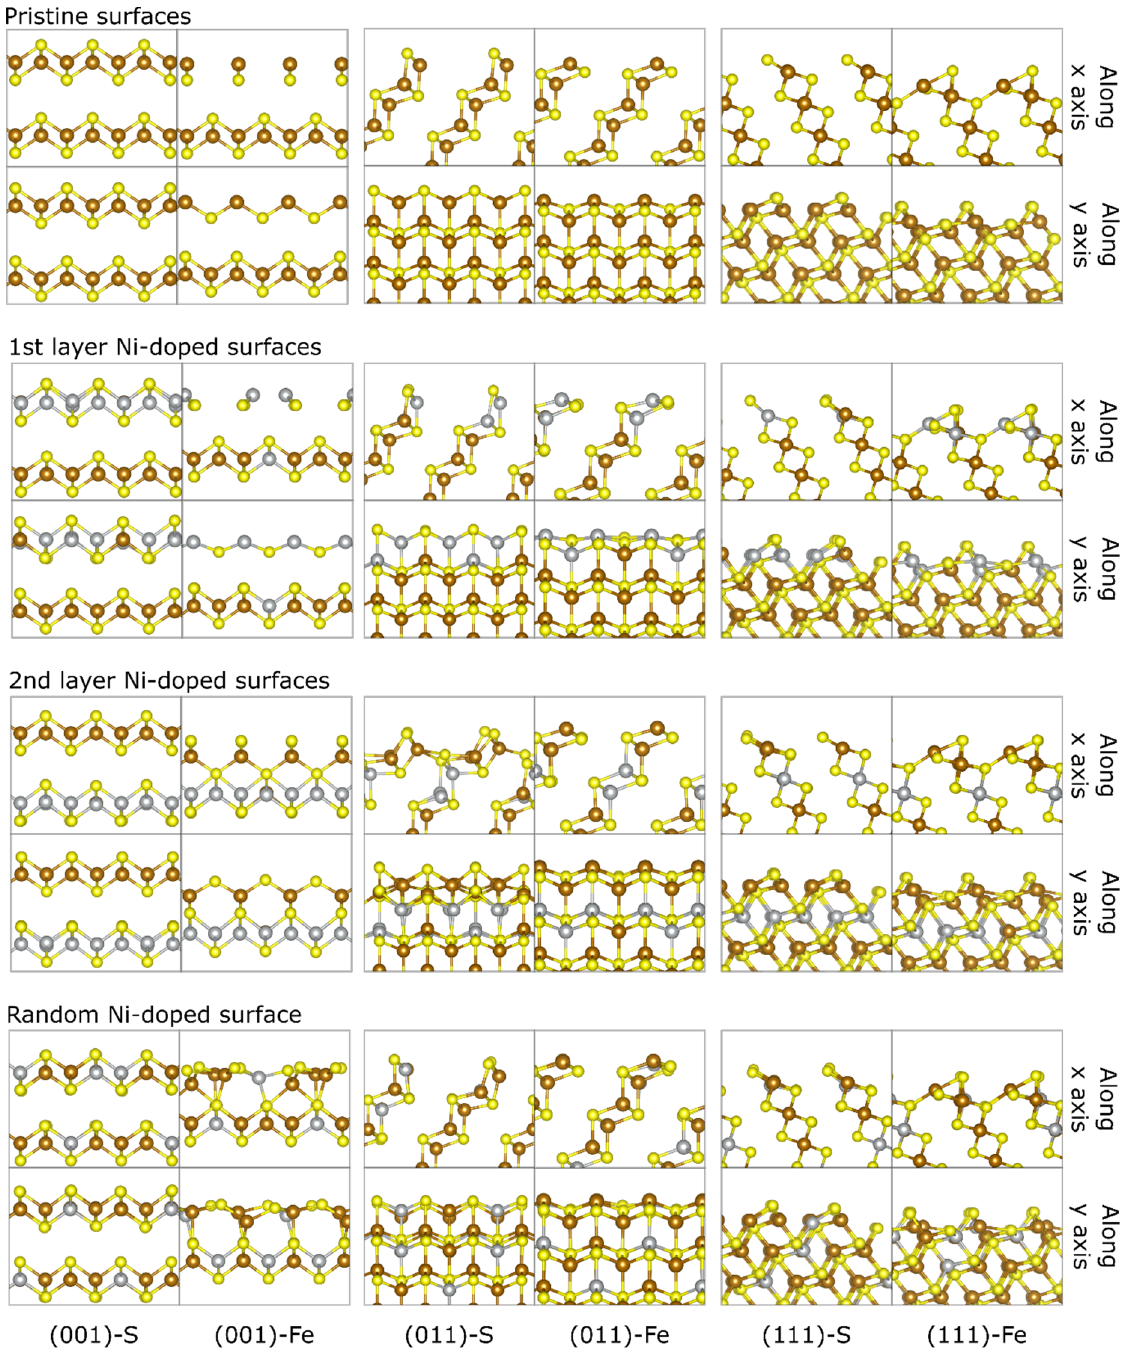
Figure 3. Optimised structures of the relaxed pristine as well as Ni-doped FeS surfaces of choice. Brown, yellow, and grey spheres represent iron, sulphur, and nickel atoms, respectively.